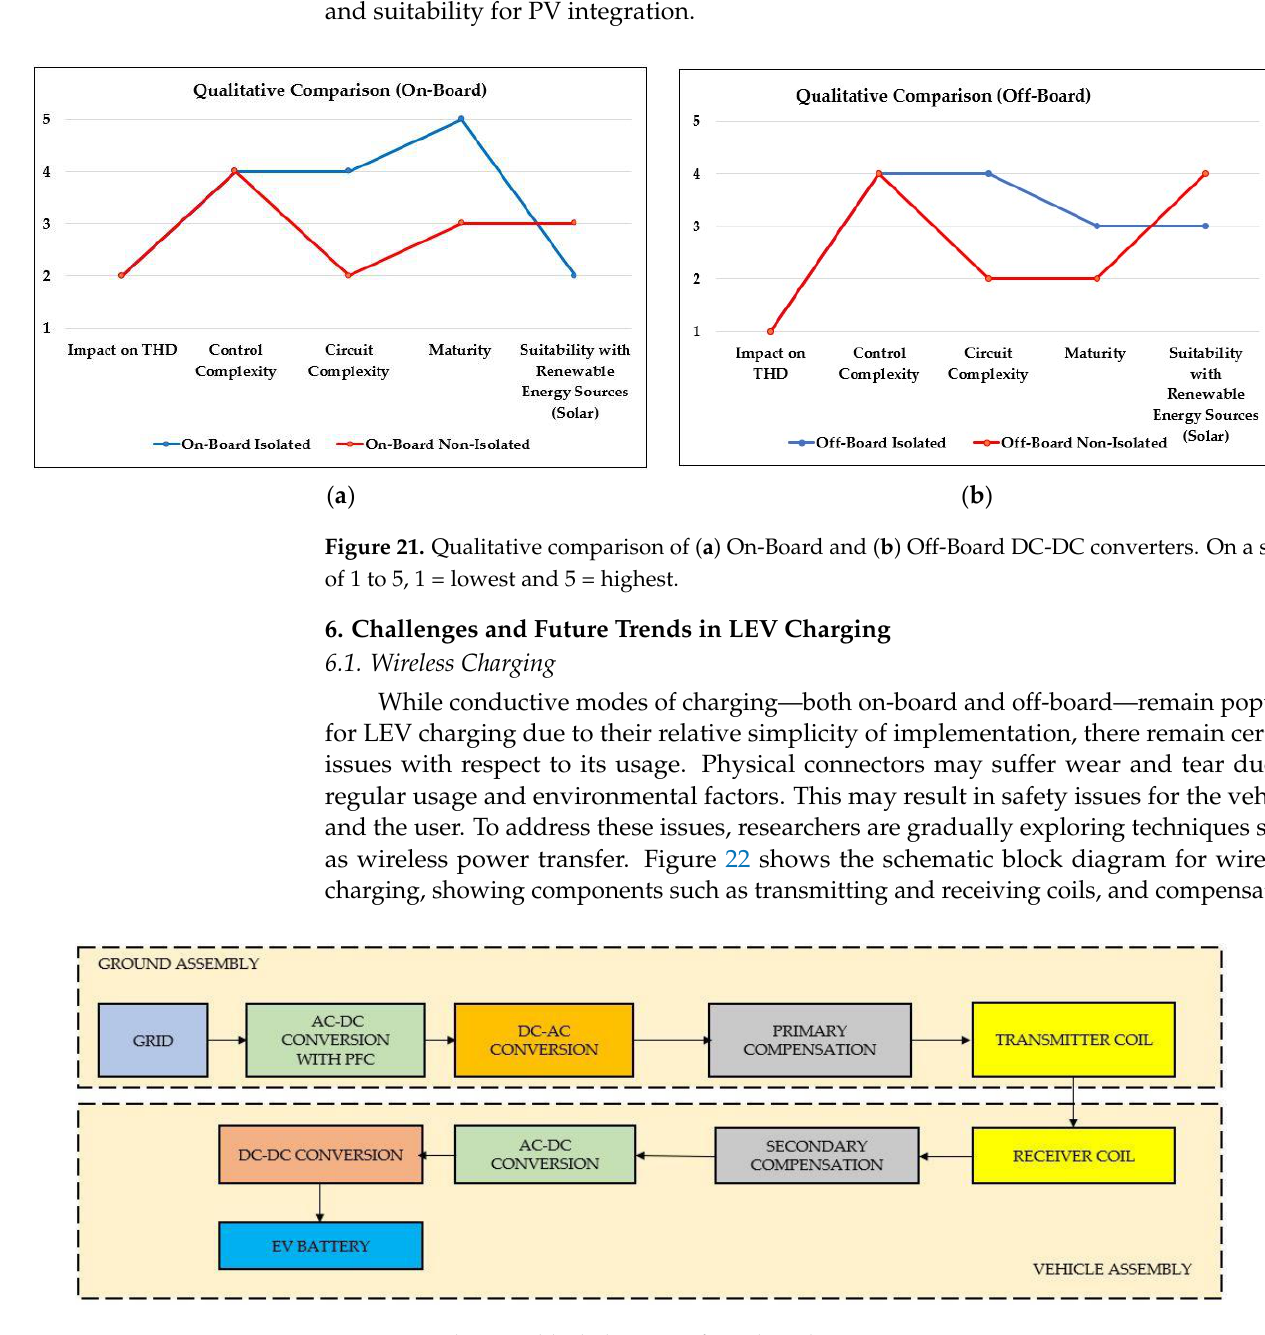
Figure 20. Distribution of reviewed papers by type and year.